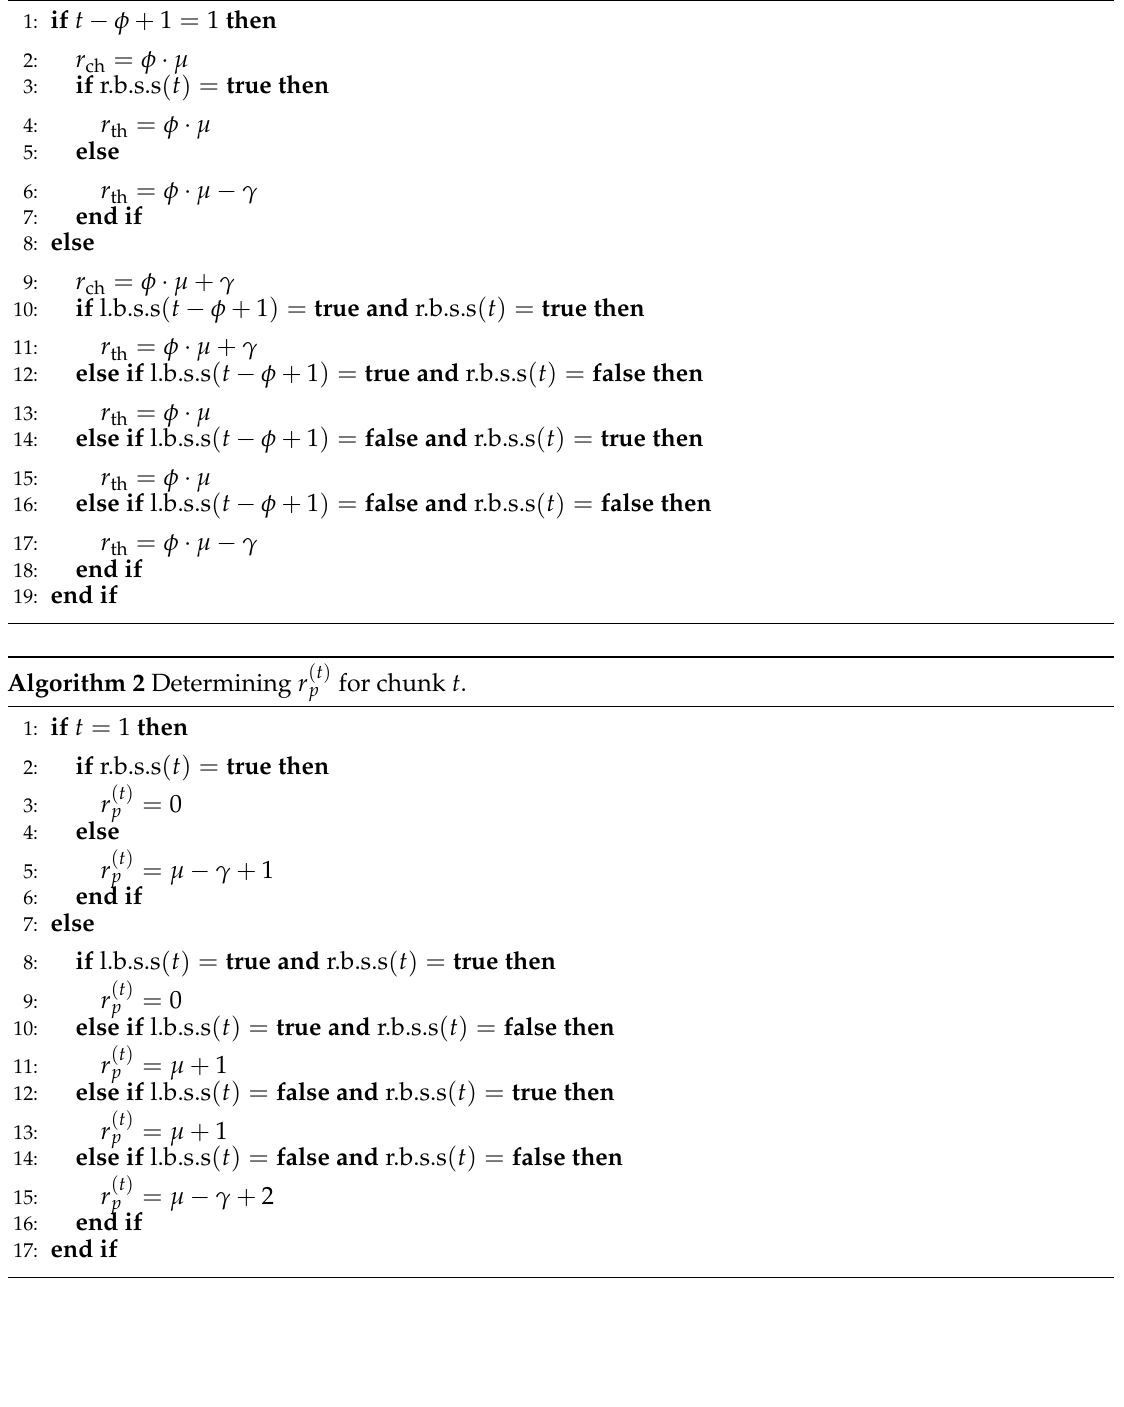
Algorithm 1 Determining r th and r ch of a co.cs starting from chunk t with length φ .